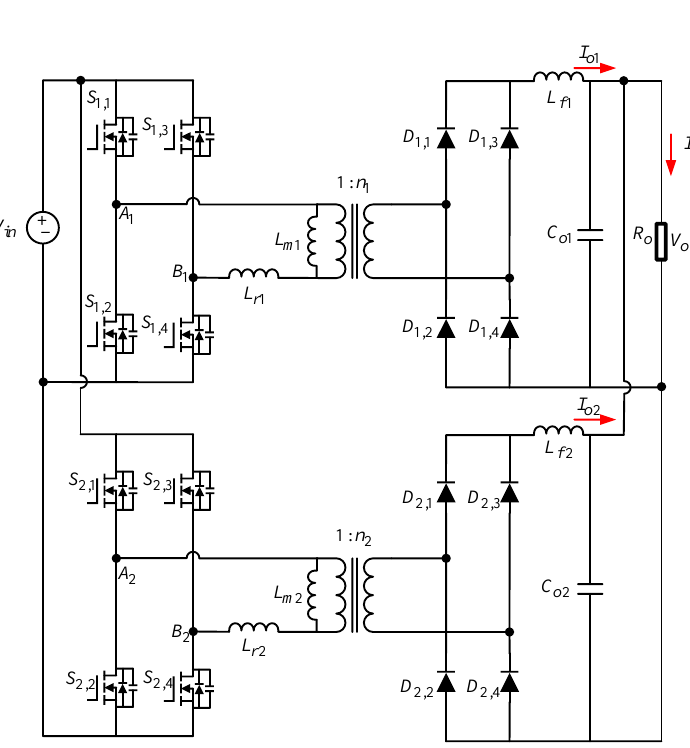
Figure 4. Two-phase parallel PSFB converter. S and 2 , 4 are the primary switches of phase #1 and phase #2, respectively. and are the rectifier diodes on the secondary side of the two phases. and 1 f L are the primary leakage inductor, primary magnetizing inductor and secondary filter inductor of phase #1, respectively. and 2 f L are the pri- mary leakage inductor, primary magnetizing inductor, and secondary filter inductor of phase #2, respectively. 1 n and 2 n are the ratio of turns of the secondary side to the pri- mary side coil of phase #1 and phase #2, respectively. in V is the DC input voltage. 1 o I , and 2 o I are the load current of the two phases, respectively. o I is the total load current. R is the total load resistor. V is the DC output voltage. o o